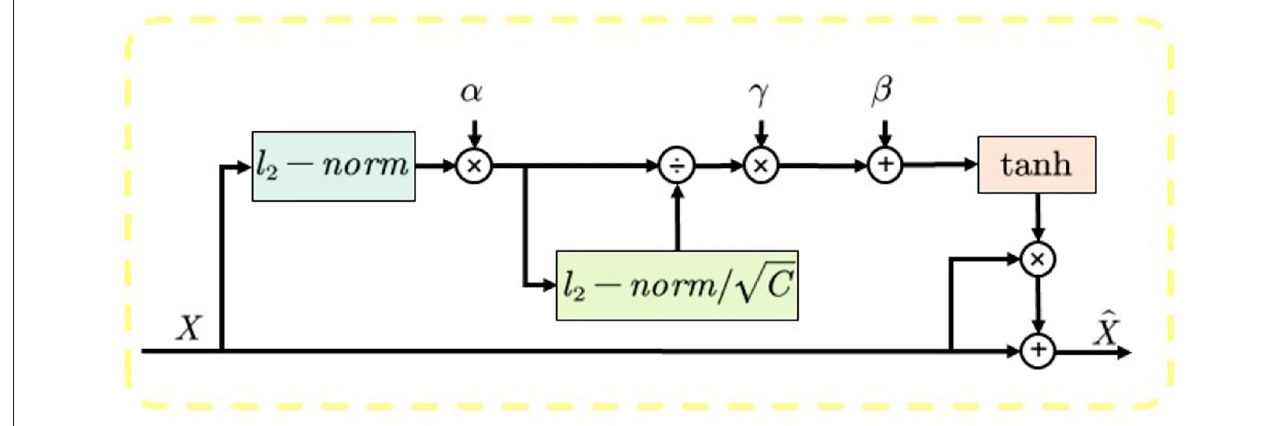
FIGURE 3 | The overall structure of Gated Channel Transformation (GCT).